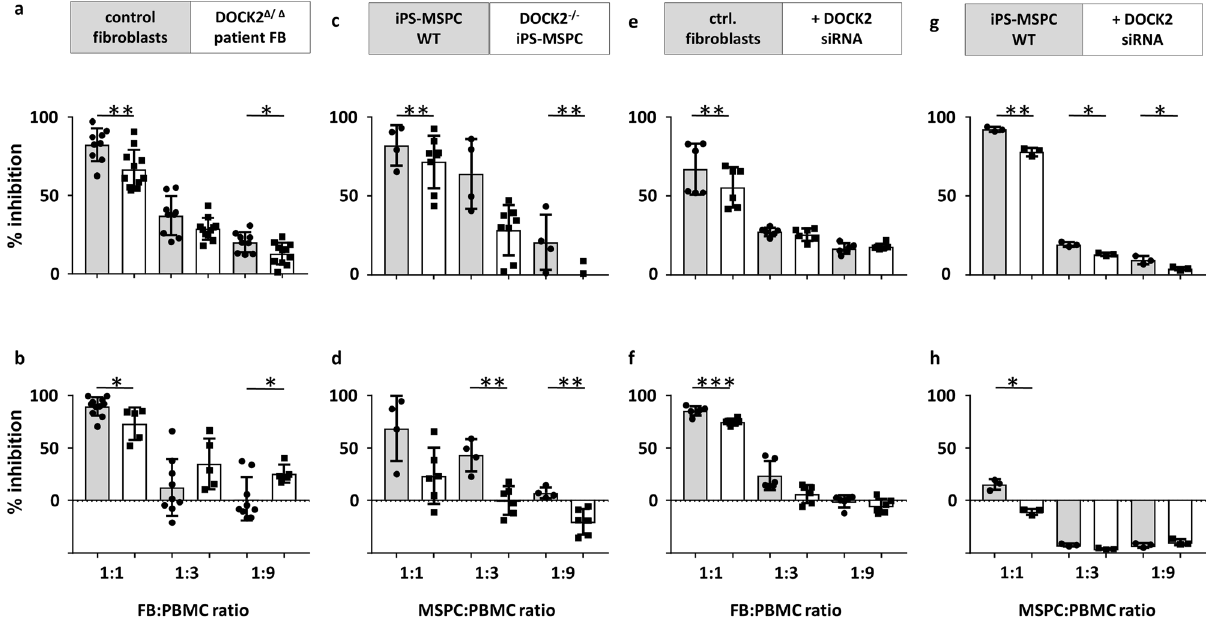
Fig. 3 DOCK2-de fi cient ( Δ / Δ ) patient fi broblasts, CRISPR/Cas9-created DOCK2-/- iPS-MSPCs and siRNA-mediated DOCK2 knockdown impaired stromal immunomodulation. ( a , c , e , g ) T cell mitogenesis and ( b , d , f , h ) allogeneic mixed leukocyte reaction (MLR). a Pooled data from two DOCK2 Δ / Δ patient ’ s fi broblasts and four different adult donor ’ s fi broblasts (control fi broblasts 1:1 n = 9, 1:3 n = 9, 1:9 n = 9, DOCK2-de fi cient fi broblasts 1:1 n = 11, 1:3 n = 11, 1:9 n = 11, for 1:1 ** p < 0.01, unpaired two-tailed t test p -value 0.0077, df = 54, 1:9 p = 0.029, df = 18). b MLR at day 7. Pooled data of the two DOCK2 patients, 5 different adult fi broblast and 2 neonatal fi broblast donors (control fi broblasts 1:1 n = 11, 1:3 n = 9, 1:9 n = 9, DOCK2-de fi cient fi